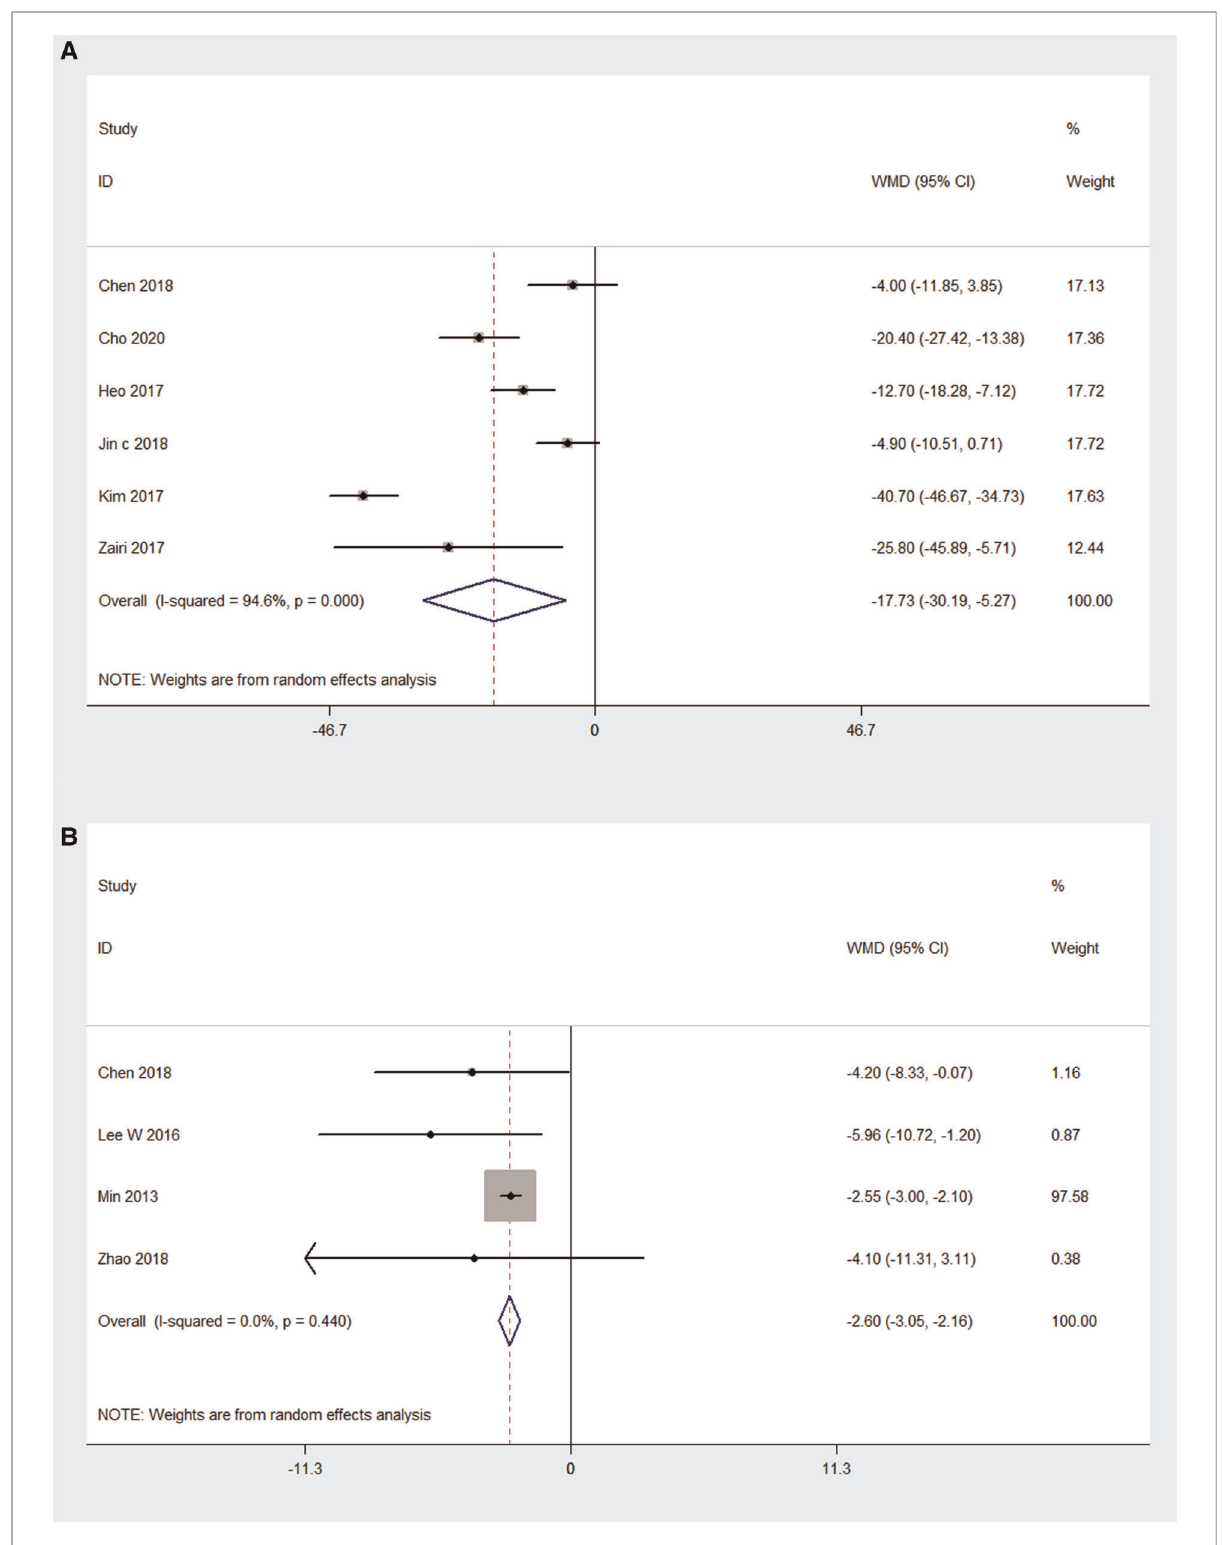
FIGURE 6 Forest plot and pooled estimates of lumbar lordotic angle. Outcomes assessed are ( A ) OLIF group; ( B ) MI-TLIF